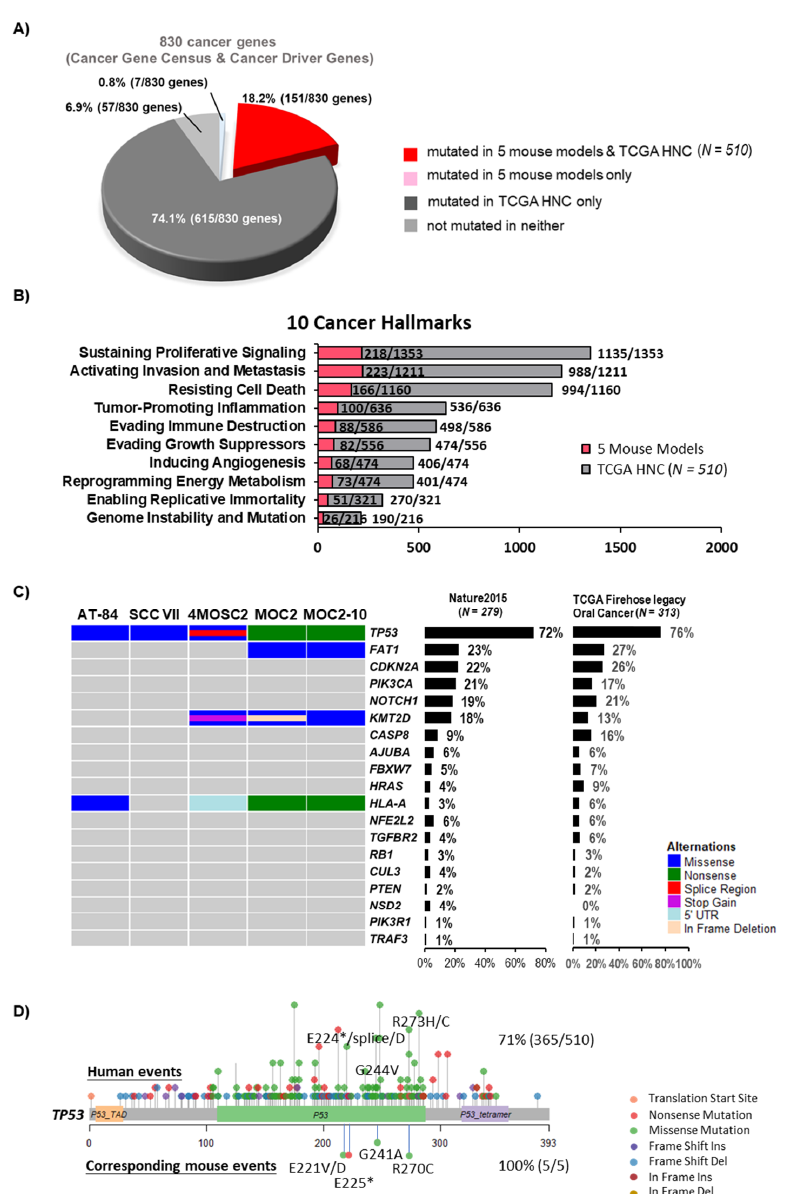
Figure 2. Mutations in mouse models show a high resemblance to human cancer. ( A ) A pie chart showing the recapitulation of cancer-related somatic mutations (830 genes) in 5 mouse cell lines vs. that of The Cancer Genome Atlas (TCGA)-HNC patient tumors ( N = 510). Cancer-related genes with or without alterations in 5 mouse cell lines or HNC patient tumors are indicated according to the legend at the bottom. ( B ) Bar graph showing the somatic mutation counts of 10 cancer hallmark gene sets harbored by 5 mouse cell lines and TCGA-HNC ( N = 510). The mutation counts of HNC patients are represented by grey bars, whereas those of mouse models are represented by red bars. ( C ) Oncoprints for 5 mouse models showing genes with statistically significantly mutated (MutSig, Q value < 0.1), with event frequencies in TCGA-HNC, all patient tumors, as well as TCGA-HNC oral tumors indicated with percentages on the right. ( D ) Mapping of mutation sites of Trp53 mutations in 5 mouse models and human TP53 hotspot mutations based on whole-exome sequencing data of TCGA-HNC ( N = 510). TCGA: The Cancer Genome Atlas.